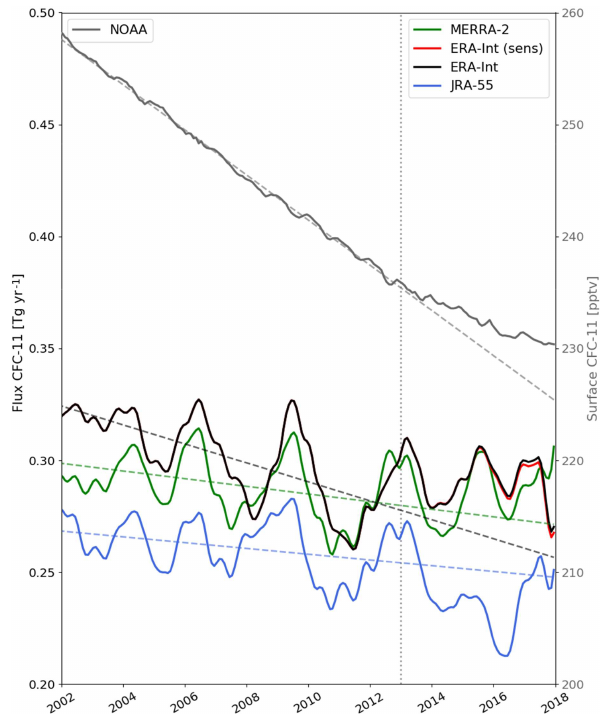
Figure 4. The annually averaged stratosphere-to-troposphere mass flux of CFC-11 through the tropopause between 2002 and 2018 for CLaMS model runs driven by MERRA-2 (green), JRA-55 (blue) and ERA-Interim (black) reanalyses including a linear regression for the period until 2013 (dashed). The red line originates from an ERA-Interim sensitivity run for which tropospheric CFC-11 was forced to continue to decrease at the same rate as before 2013. Shown in grey and on the right-hand y axis are the two correspond- ing time series of tropospheric CFC-11 mixing ratios (i.e. the real one, solid, and the one with the forced decrease, dashed). The an- nual average has been calculated by applying a 12-month running mean to the time